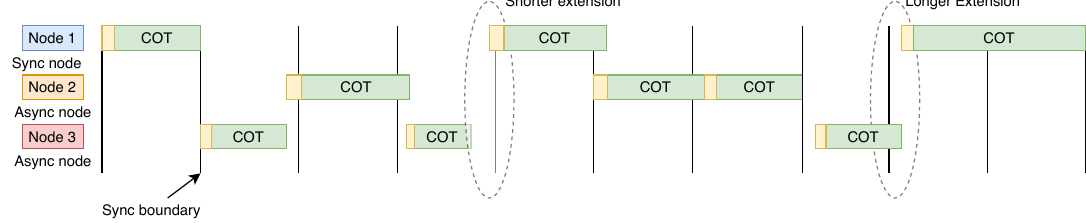
Figure 7. Coexistence of synchronous and asynchronous